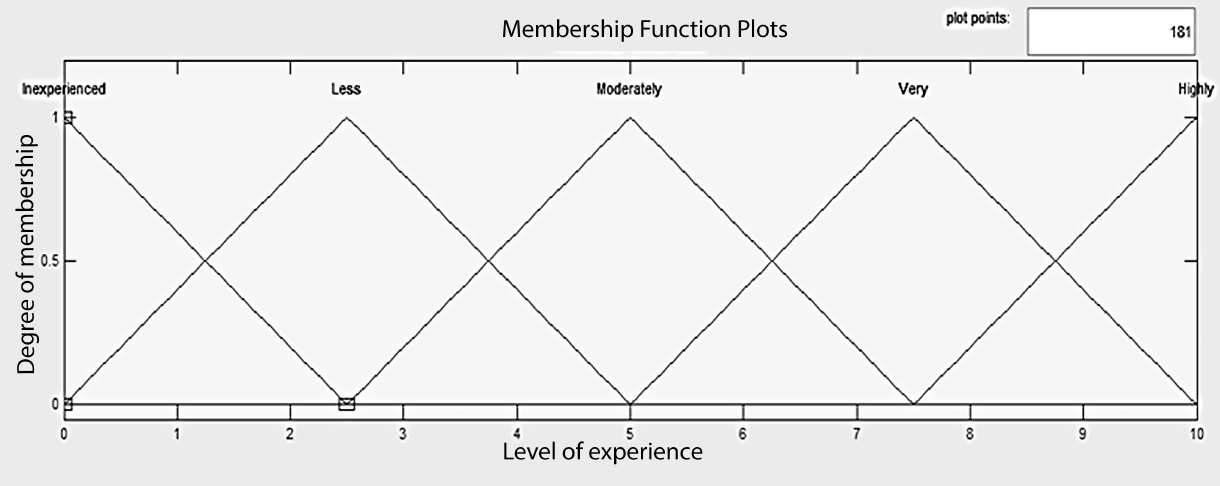
Fig 2. Output sets of the final fuzzy model: Levels of running experience.